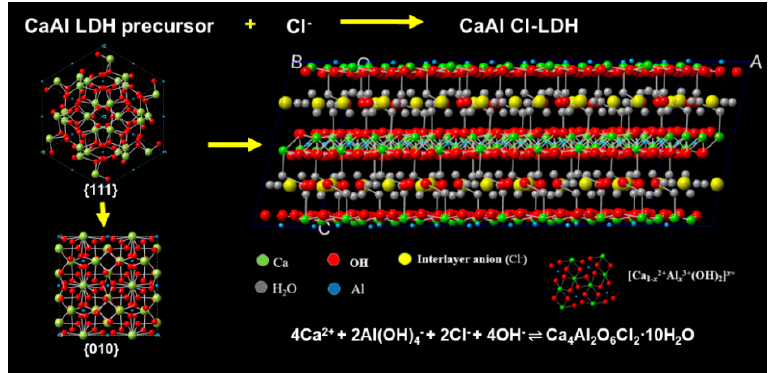
Figure 4. Calculated structures of CaAl LDH precursor and CaAl-Cl LDH. Color key: Green, blue and yellow spheres represent Ca, Al and Cl atoms, respectively. Red and grey spheres represent H 2 O and OH group.